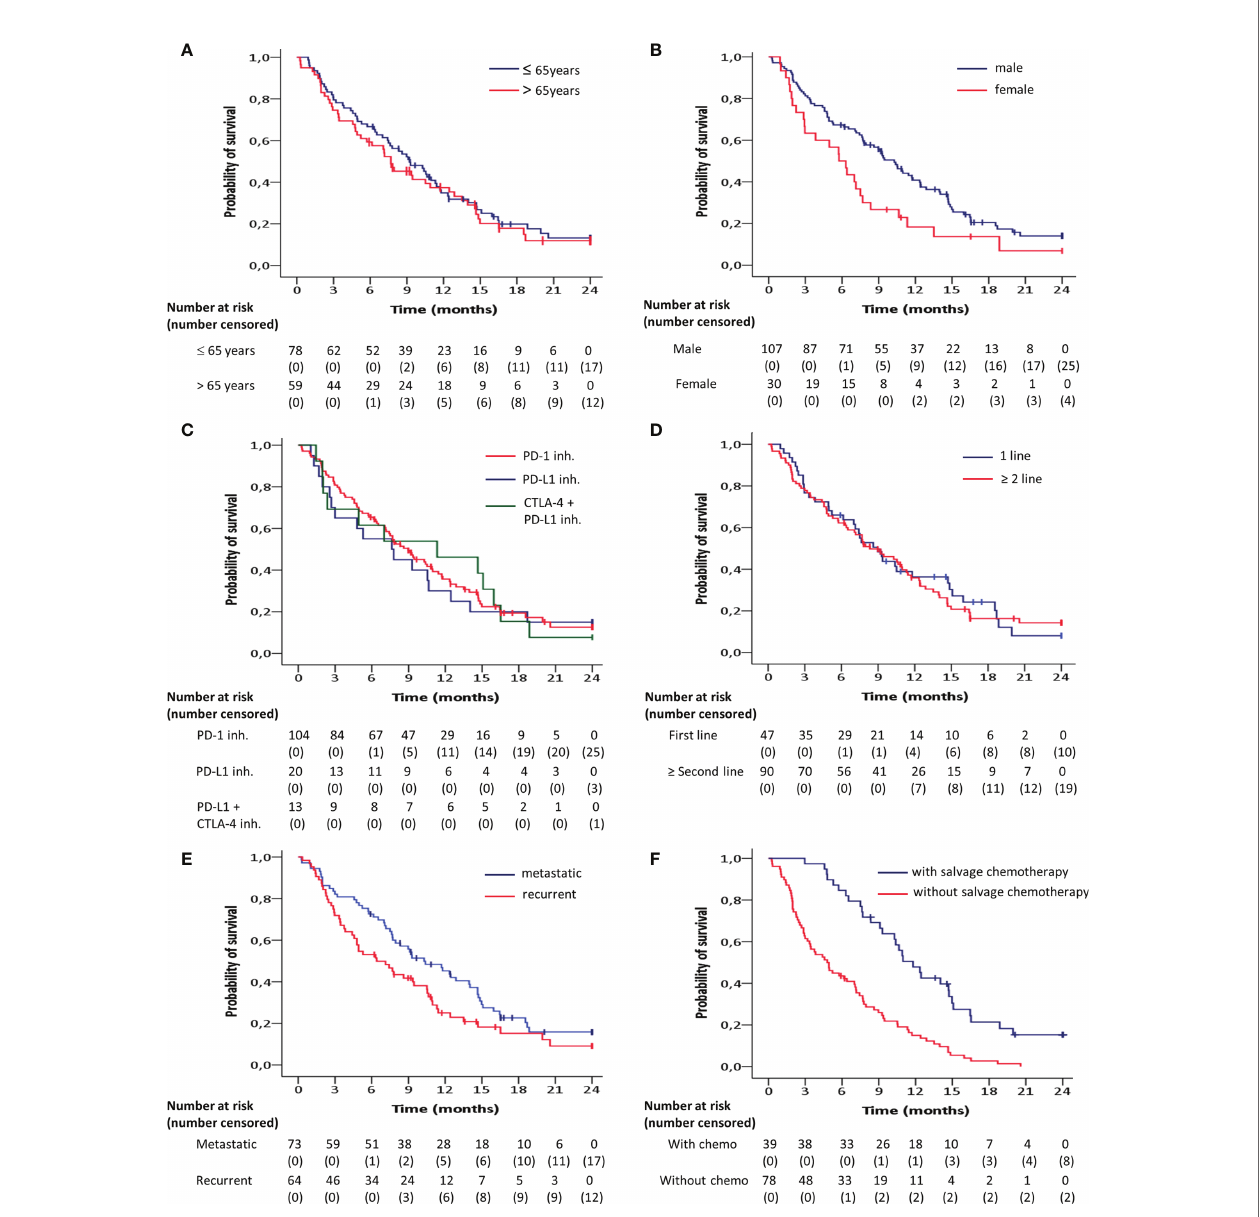
FIGURE 2 | Kaplan-Meier curves for overall survival according to (A) age, (B) gender, (C) target inhibitor, (D) line of treatment and (E) recurrence pattern, estimated for the entire patient group (n=137). (F) Overall survival for the subgroup of patients with tumor progression after immune checkpoint blockade treatment (n=117) depending on whether subsequent salvage chemotherapy was administered. Overall survival was signi fi cantly (p<0.05) longer in men compared to women, in metastatic tumors compared to locoregionally recurrent HNSCC and in patients who received subsequent salvage therapy compared to those